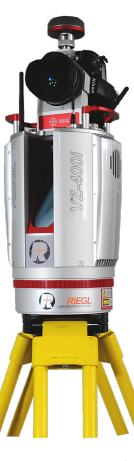
Figure 8. Riegl VZ-400i TLS [61].